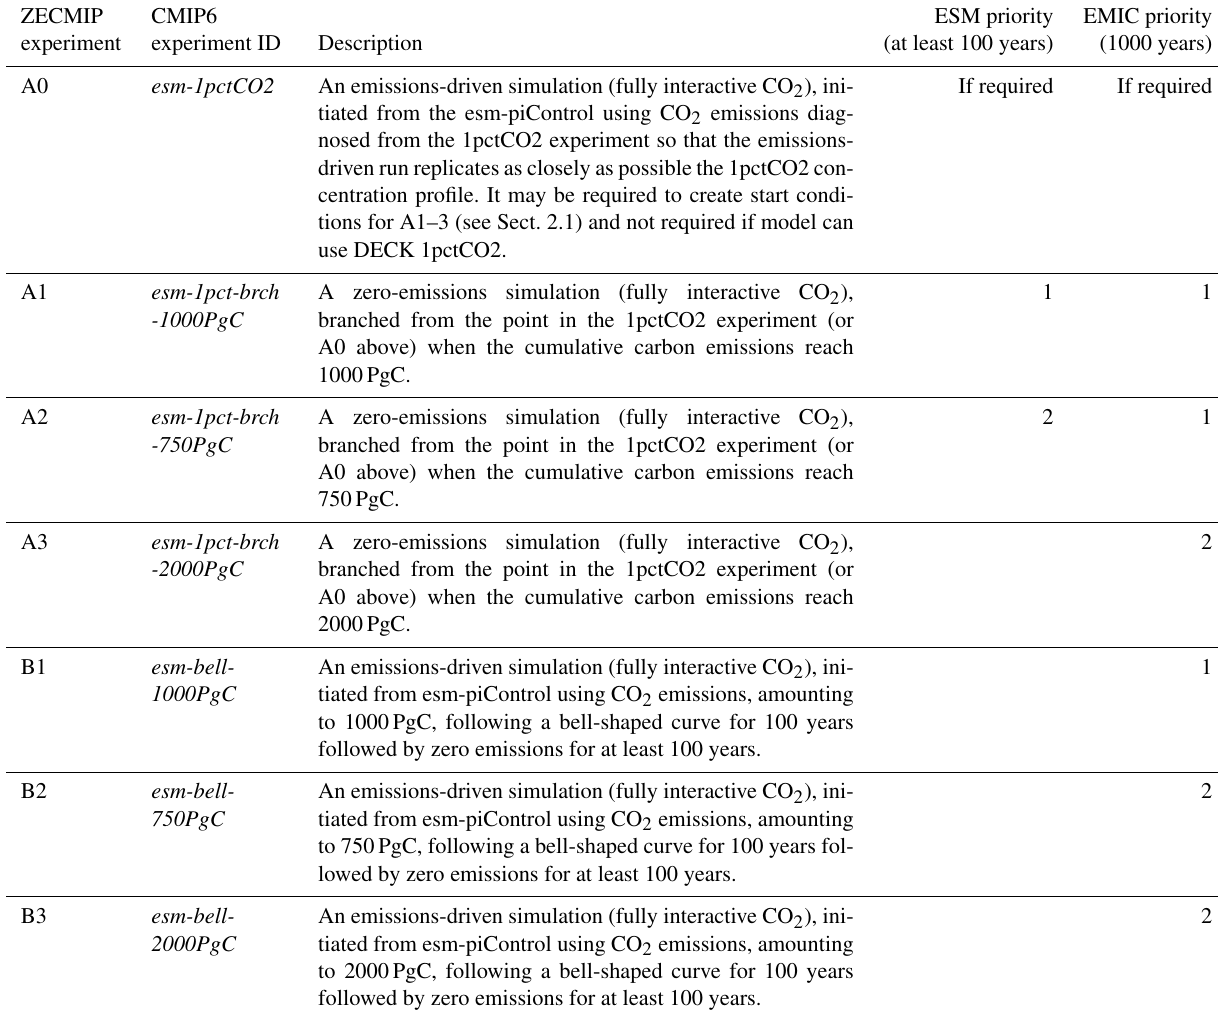
Table 1. ZECMIP simulations and priorities for ESMs and